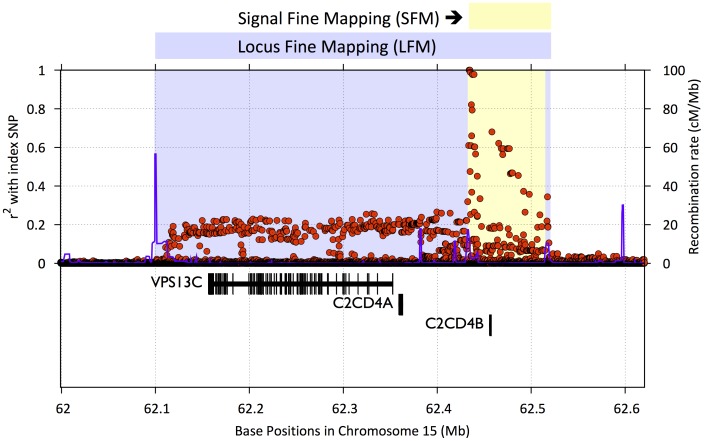
Example of signal fine mapping (SFM) and locus fine mapping (LFM) regions.A SFM region seeks to map the initial association signal. SFM regions were designed using linkage disequilibrium (LD) r2 estimates from the 1000 Genomes Project and HapMap CEU data. Initial boundaries were determined by identifying all SNPs satisfying r2≥.5 with the index SNP, and then expanded to the nearest flanking recombination hotspot, but stopped if there was no hotspot nearby. LFM regions (blue) were similarly designed but expanded to capture functional units of interest such as nearby coding genes. The figure plots LD r2 for SNPs (red dots) within the region and recombination rate (blue lines) as a function of position on the chromosome. Gene positions and structures are displayed in the lower panel. MI = myocardial Infarction; CAD = cardiovascular disease; HDL = high-density lipoprotein; LDL = low-density lipoprotein; T2D = type 2 diabetes.